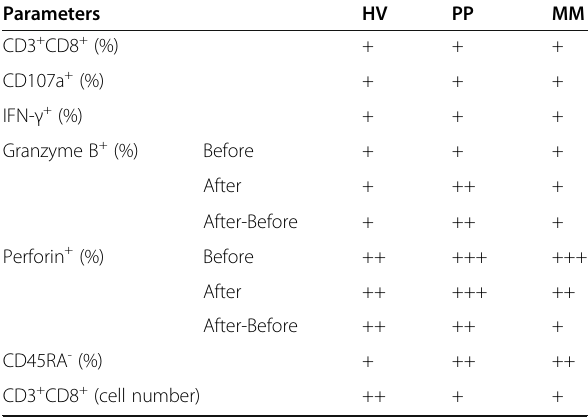
Table 2 Functional properties of CD8 + lymphocytes in individuals with pleural plaque and patients with